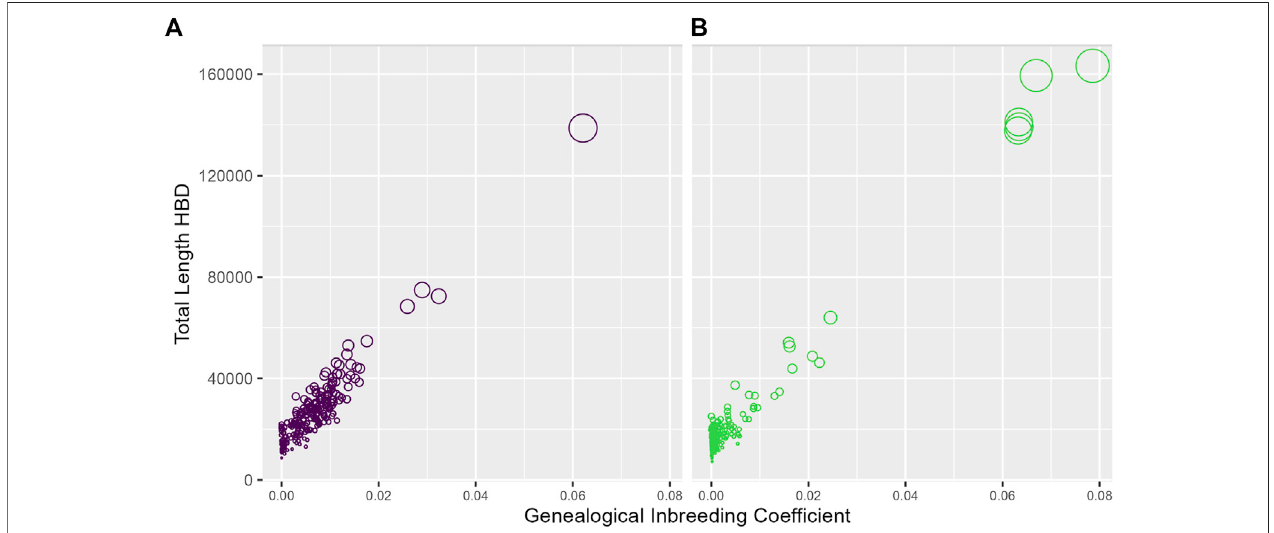
FIGURE 2 | Genomic and genealogical homozygosity by descent (HBD). For each proband, the total length of simulated segments inferred HBD based on IBDLD HBD probabilities of at least 0.5 is plotted against the proband ’ s genealogical inbreeding coef fi cient. The size of the points is proportional to the number of replicates in which the proband has a segment HBD. (A) SLSJ study; (B) Montreal